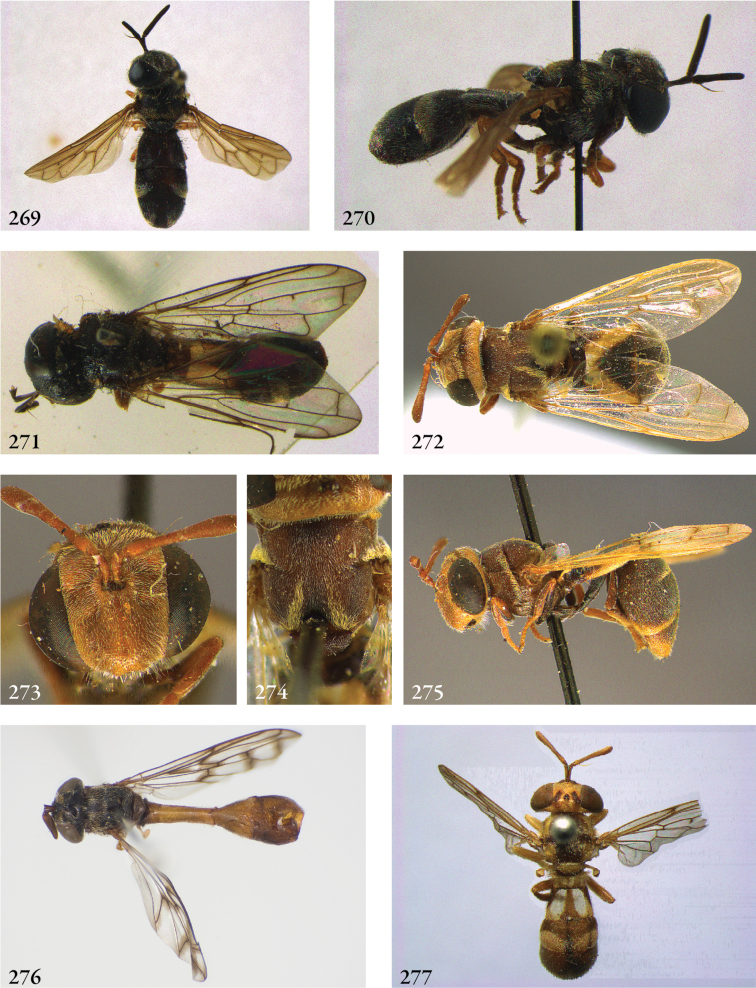
269–270
Paramixogaster acantholepidis male (holotype): 269 habitus dorsal 270 habitus lateral 271
Paramixogaster luxor male (holotype), habitus dorsal 272–275
Paramixogaster piptotus female (holotype): 272 habitus dorsal 273 head frontal 274 thorax dorsal 275 habitus lateral 276–277
Paramixogaster, habitus dorsal: 276
Paramixogaster omeanus male (holotype) 277
Paramixogaster vespiformis female (syntype).